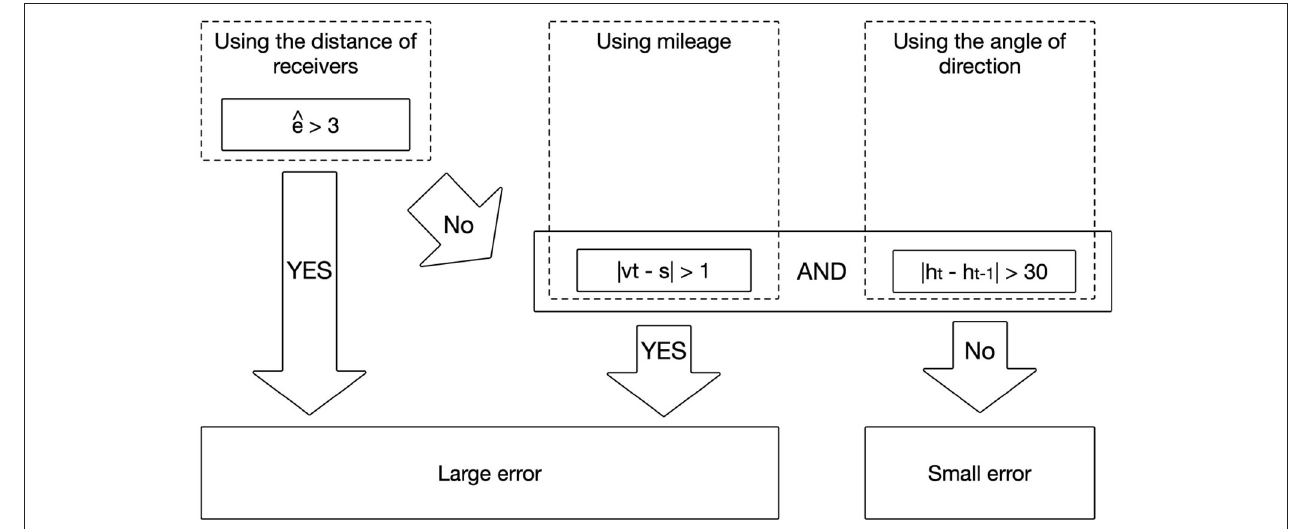
FIGURE 8 | Migration of the